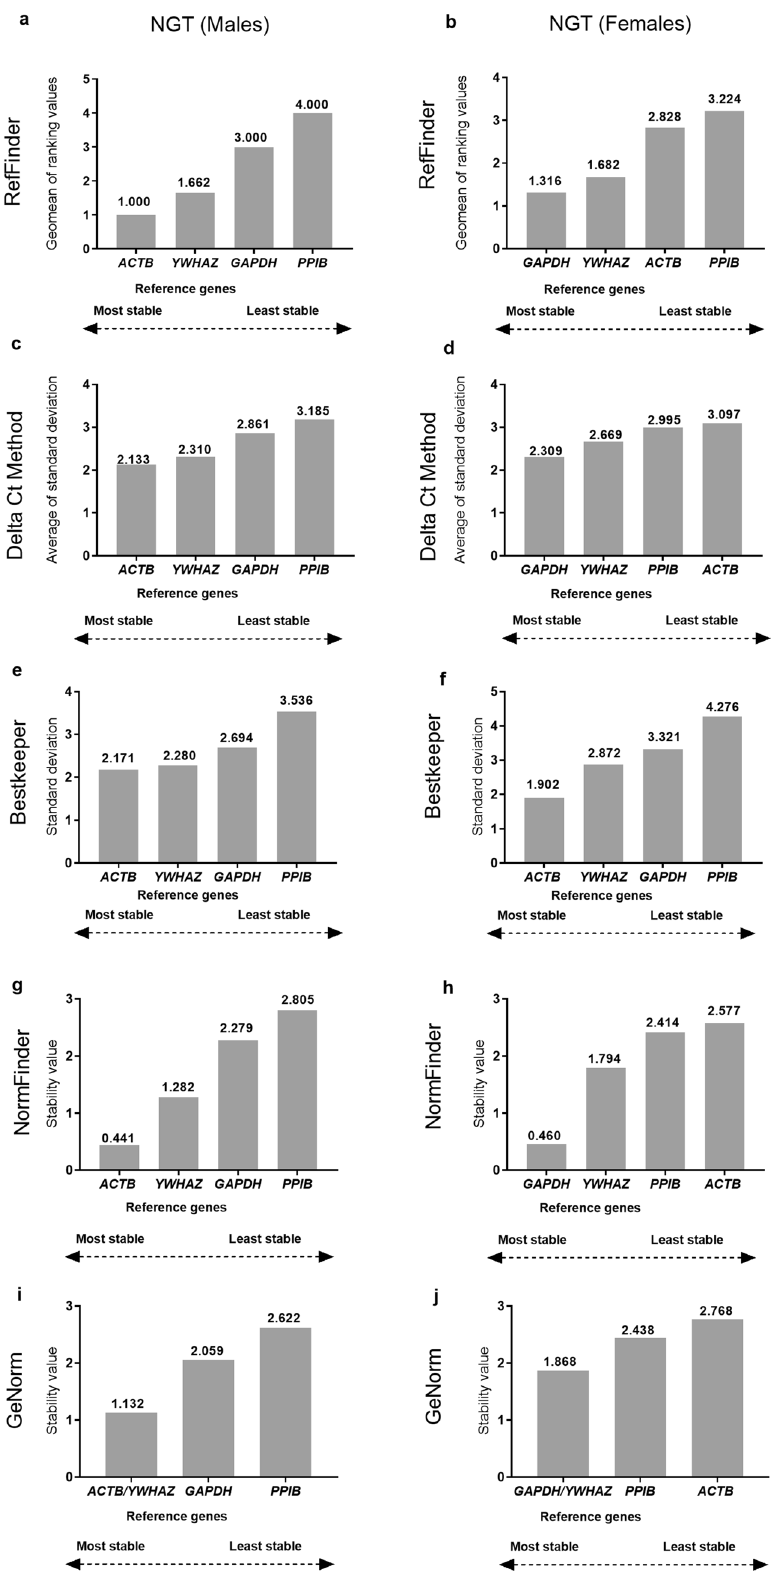
Figure 2. Gender-based expression stability analysis and ranking of the 4 reference genes provided by RefFinder tool and different algorithms considered by RefFinder for the NGT group (n = 47) and separately for NGT Males (n = 29) and NGT Females (n = 18). Comprehensive ranking of the reference genes provided by RefFinder for ( a ) Males, ( b ) Females; ranking of the reference genes by Delta Ct method 41 for ( c ) Males, ( d ) Females; BestKeeper 40 for ( e ) Males, ( f ) Females; NormFinder 39 for ( g ) Males, ( h ) Females; and GeNorm 37,38 , based on average stability value (M value) for ( i ) Males, ( j ) Females; The most stable genes are on the left side and the least stable genes are arranged on the right side. The stability values, for each gene are indicated as data labels on the